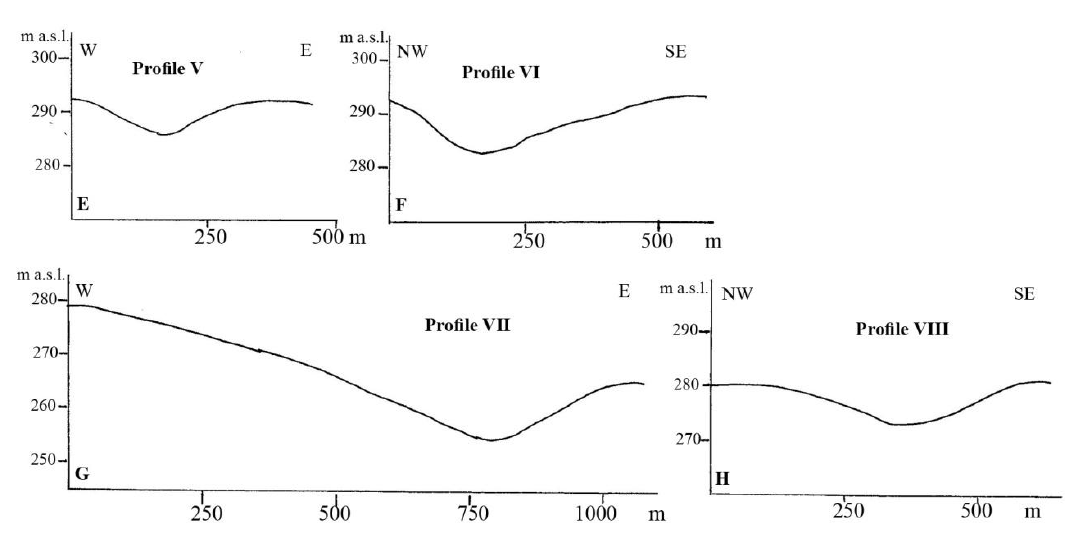
Fig. 2. Examples of transverse profiles through the valleys in the Kłokocinka catchment Table 3. Index of ventilation D and weighted mean value of the index of effective ventilation De w for selected transverse profiles through the Kłokocinka valley Profile number